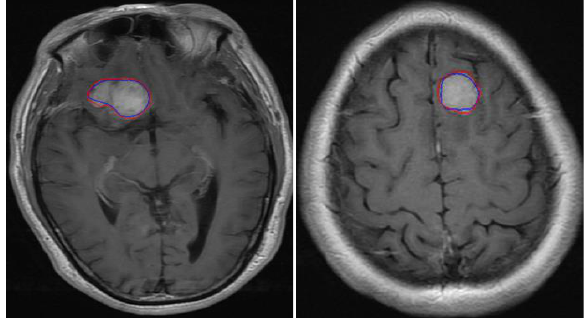
Figure 14. Segmentation of the brain tumour performed by the proposed algorithm (blue) and manual delineation (red)